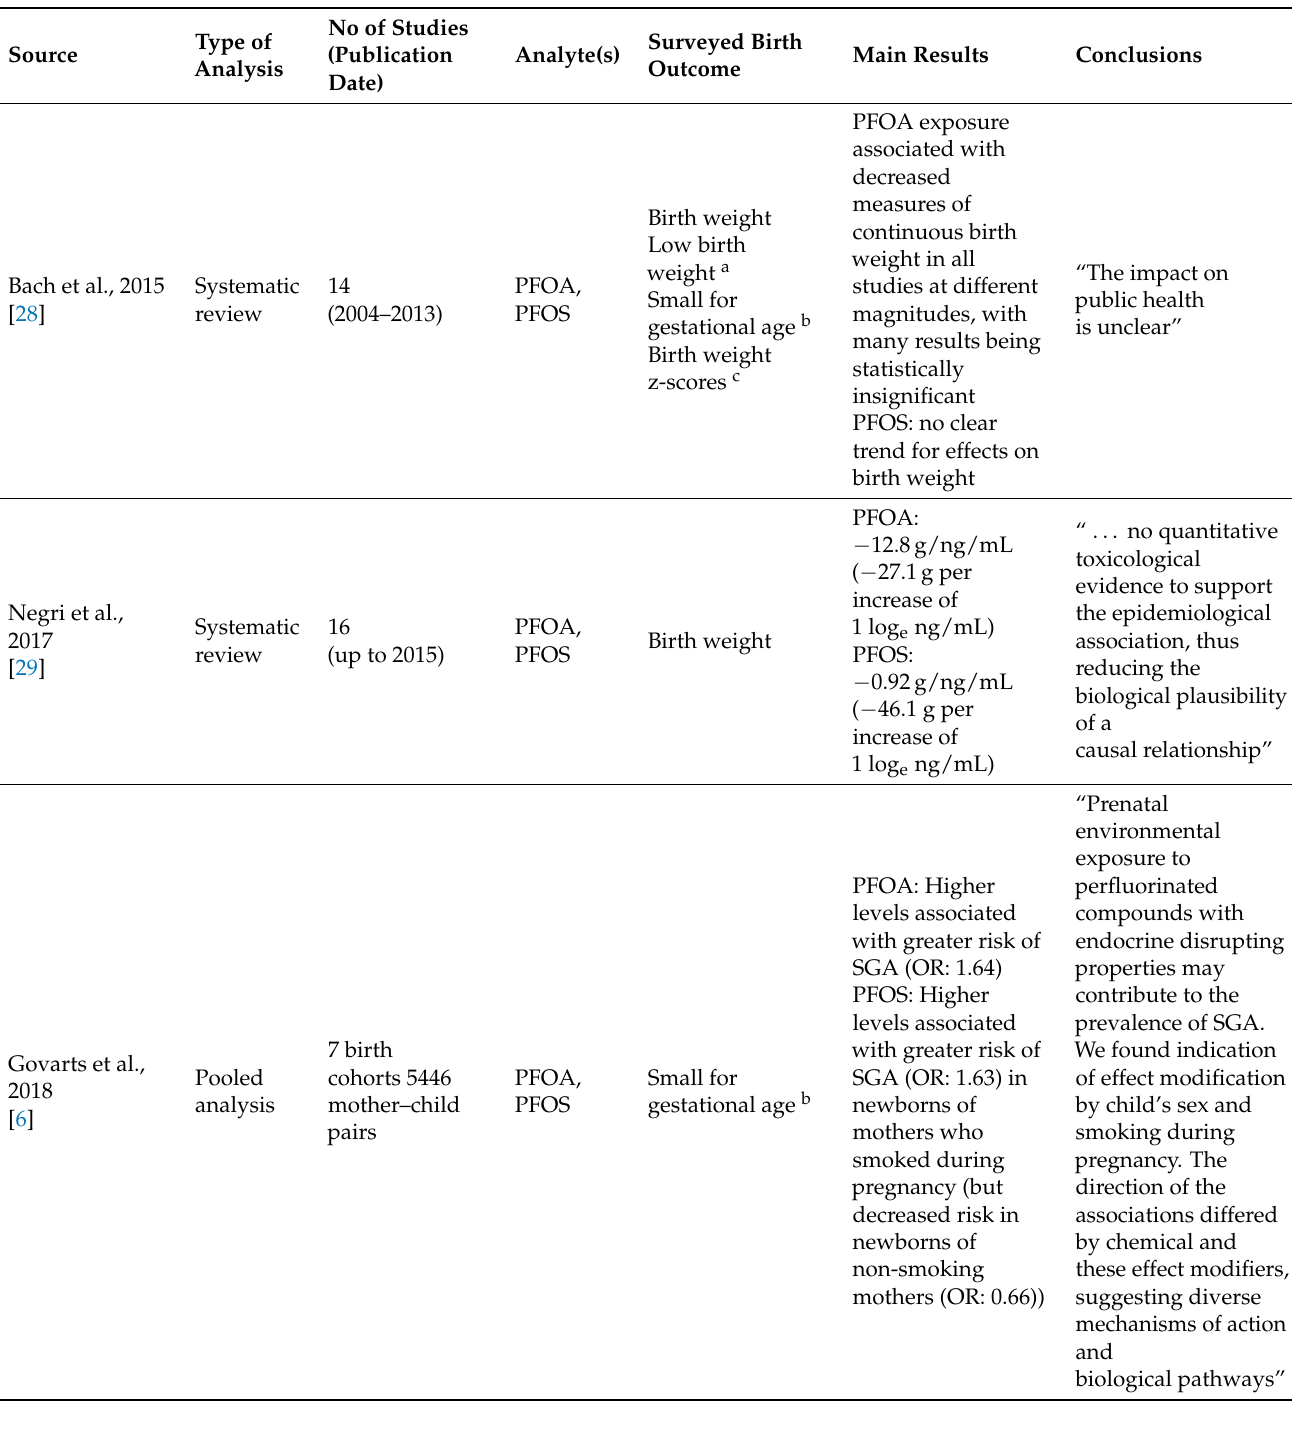
Table 1. Reviews analyzing epidemiological studies for associations between prenatal PFAS exposure and birth weight